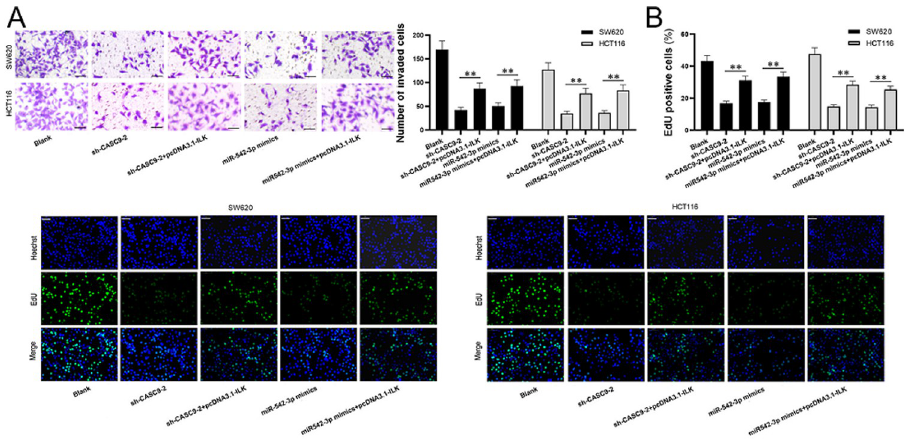
Fig 7. Overexpression of ILK significantly restores the proliferation and invasion of CRC cells with downregulated lncRNA CASC9 or upregulated miR-542-3p. 5 groups were designed, they are blank, sh- CASC9 -2, sh- CASC9 -2+pcDNA2.1-ILK, miR-542-3p mimics, and miR-542-3p mimics+pcDNA3. Black represents SW620 and grey represents HCT116 in histograms. (A) Transwell was used for invasion on 5 subsets of SW620 and HCT116 cell lines. Both down-regulating lncRNA CASC9 and up-regulating miR-542-3p could inhibit the invasion, while overexpression of ILK could significantly restore part of proliferation which is inhibited by downregulated lncRNA CASC9 and upregulated miR-542-3p, not only in SW620 but also in HCT116. (B) Edu assay was determined by comparing the proliferation among 5 groups. Compared to down-regulating lncRNA CASC9 and up-regulating miR- 542-3p, overexpression of ILK significantly improved the proliferation inhibited by downregulated lncRNA CASC9 and upregulated miR-542-3p. Histograms are the quantitative analysis of pictures. Scale bar = 50 μ m. � P < 0.05 and �� P <